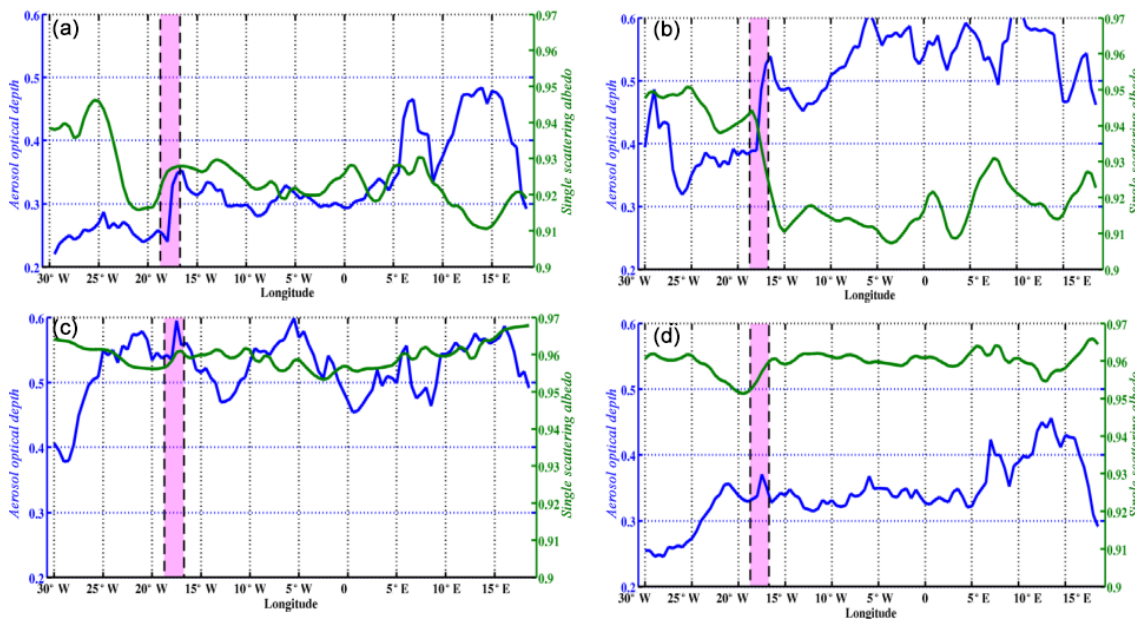
Figure 4. Seasonal SeaWiFS AOD at 550nm (blue), Aura/OMI SSA (green) zonally averaged between 12 and 21 ◦ N and from 2005 to 2010: (a) DJF; (b) MAM; (c) JJA; and (d) SON. The black dashed lines indicate the continent–ocean transition for the latitude range 12–21 ◦